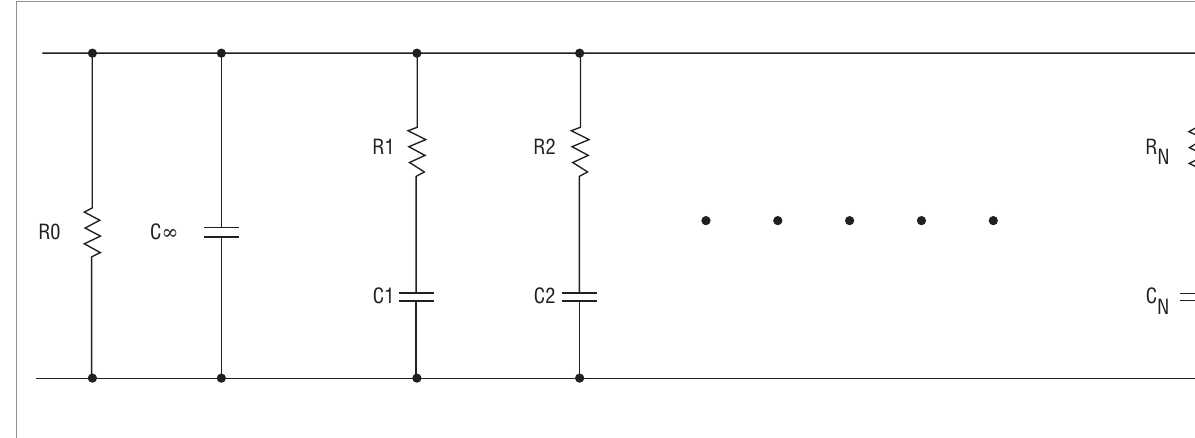
Figure 3: Universal resistor–capacitor (RC) network of the characteristics of ground as a conductor.